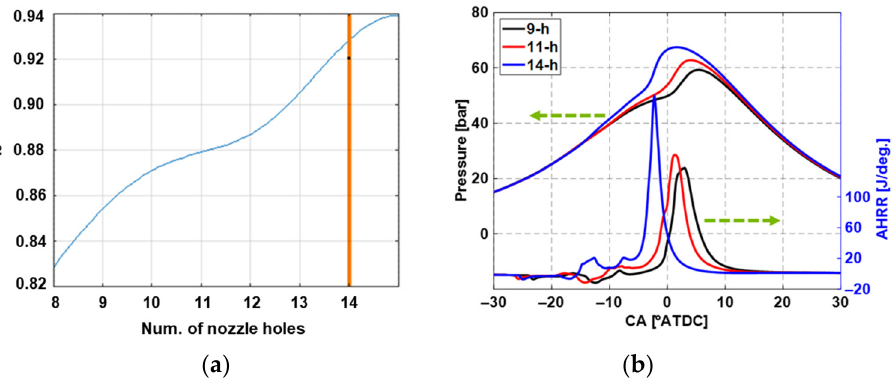
Figure 9. ( a ) The 2D response surface between combustion efficiency (ŋ c ) and the number of nozzle holes; ( b ) in-cylinder pressure and apparent heat release rate (AHRR) in different numbers of noz- zles.